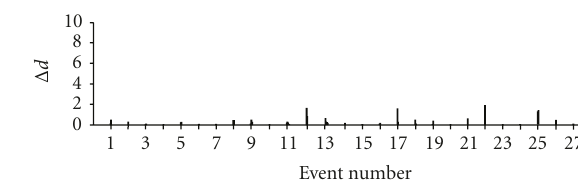
Figure 7: Excessive distances Δ d over the threshold T Δ d for the 27 detected events with distances beyond the control limits in the normal 2-day laboratory video sequence. (The length of each event in the x -axis represents the event duration.)